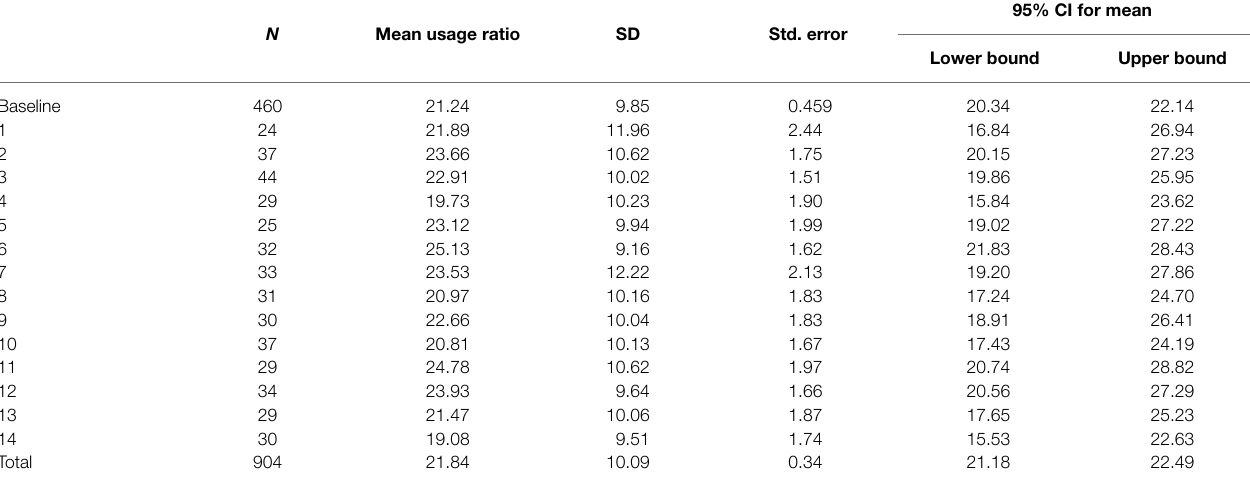
TABLE 2 | Descriptive statistics of each message type displayed on the hand sanitizer dispenser (mean and CI).